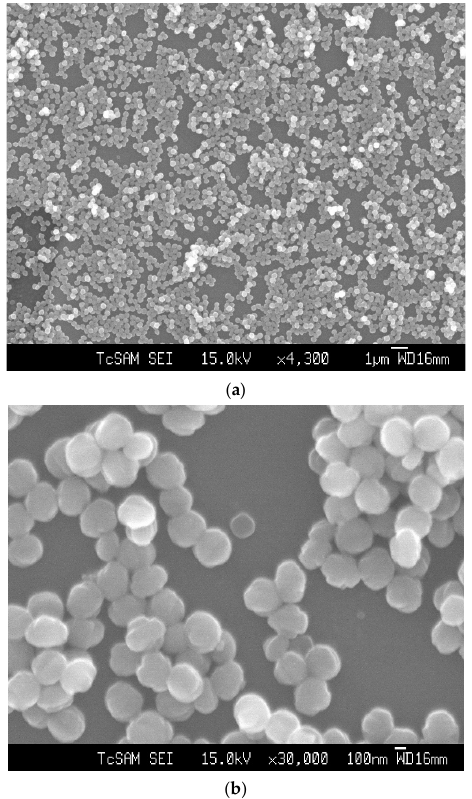
Membranes 2022 , 12 , x FOR PEER REVIEW Figure 2. SEM images of seed silicalite-1 at ( a ) low magnification and ( b ) high magnification.